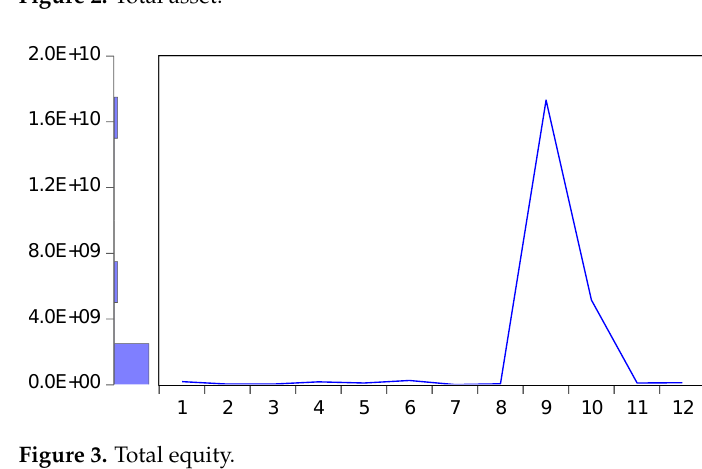
Figure 2. Total asset.